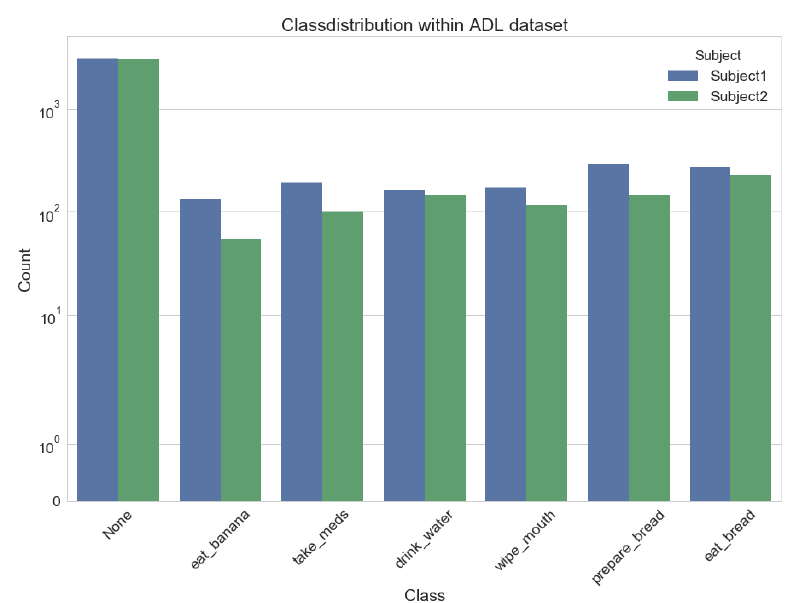
Figure 1. Distribution of classes per test subject using logarithmic scale as the majority of class labels belong to the none class. It can be seen that the majority class (excluding the none class) changes for each subject.